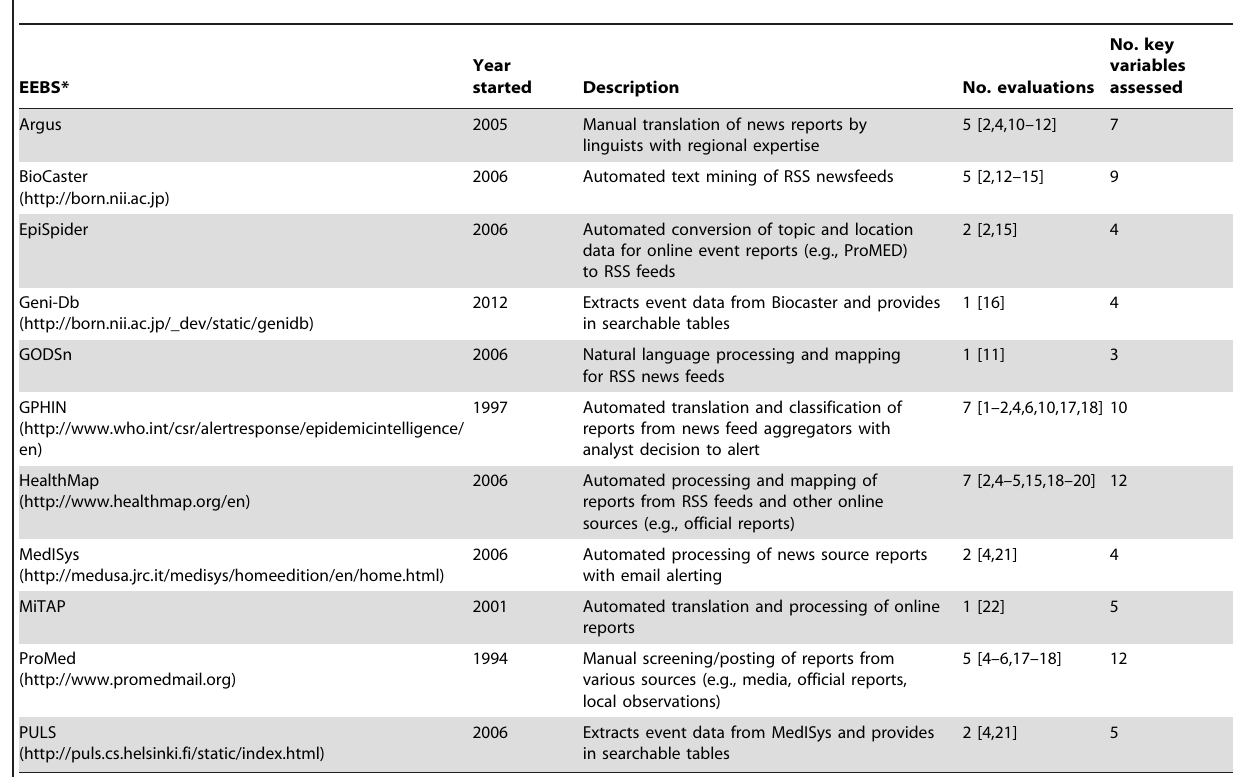
Table 1. Number of published evaluations and variables on identified